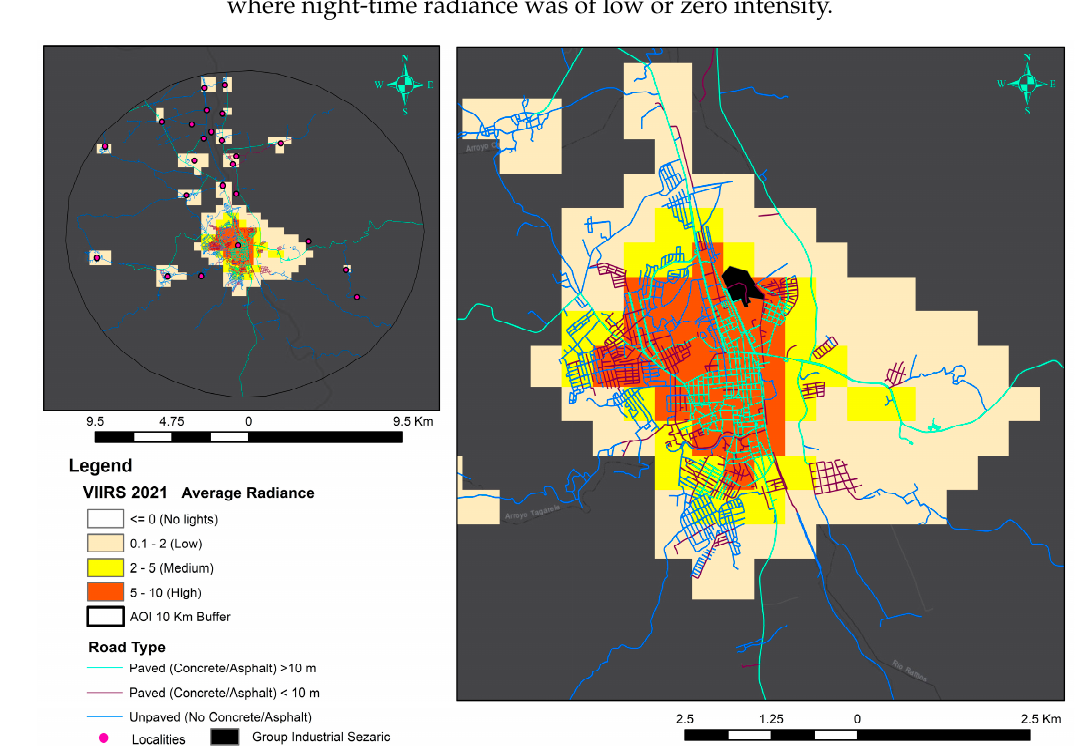
Figure 9. Roads’ states and VIIRS 2021 average radiance.